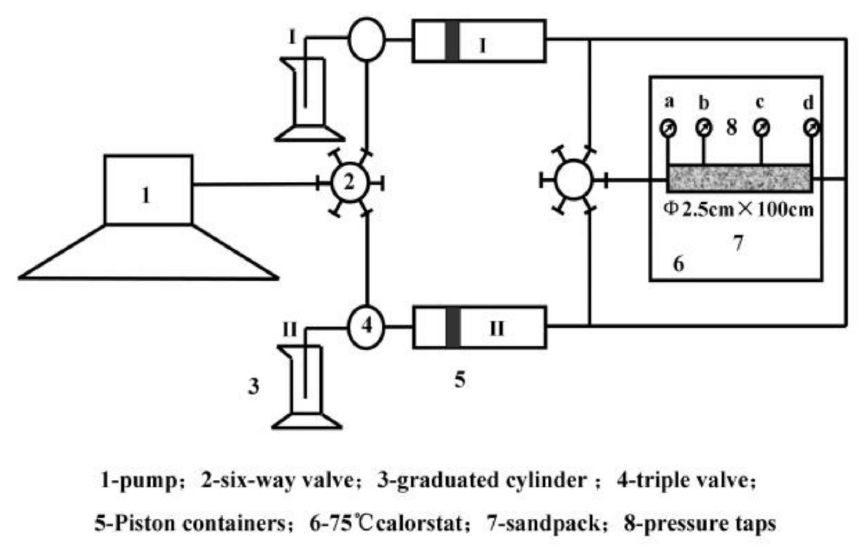
Figure 9. Schematic of circulated equipment for dynamic gelation in porous